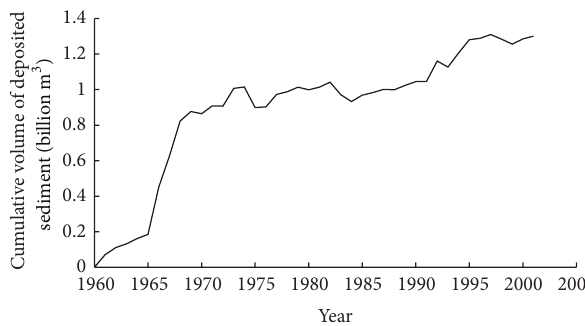
Figure 2: Cumulative volume of deposited sediment in the channel of the lower Weihe